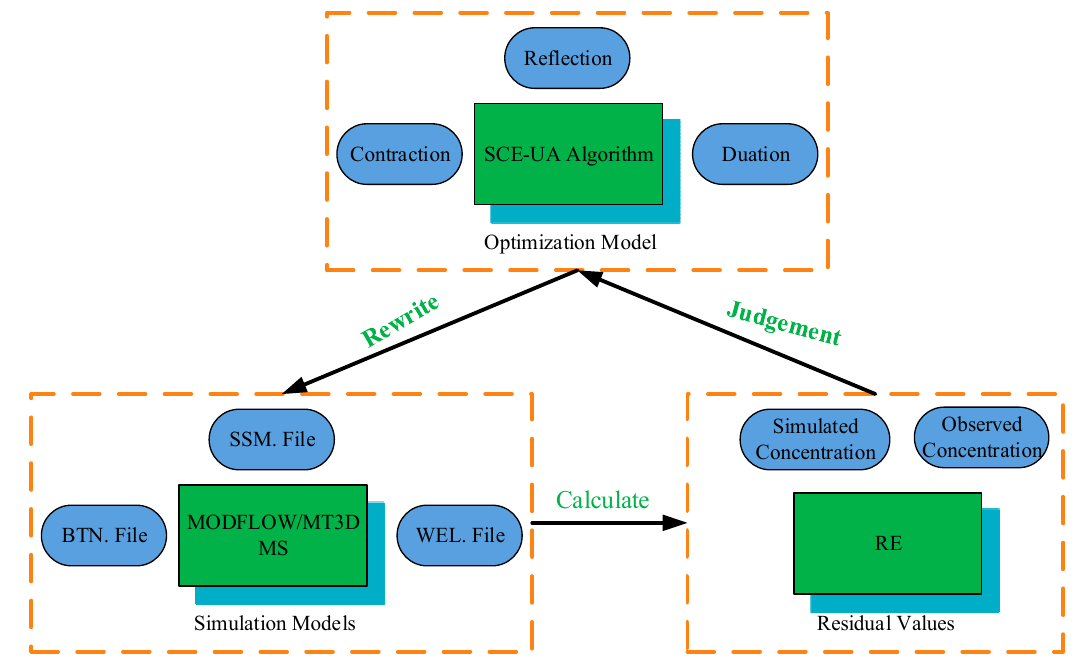
Figure 4. The link of simulation and optimization models. RE: residual error.